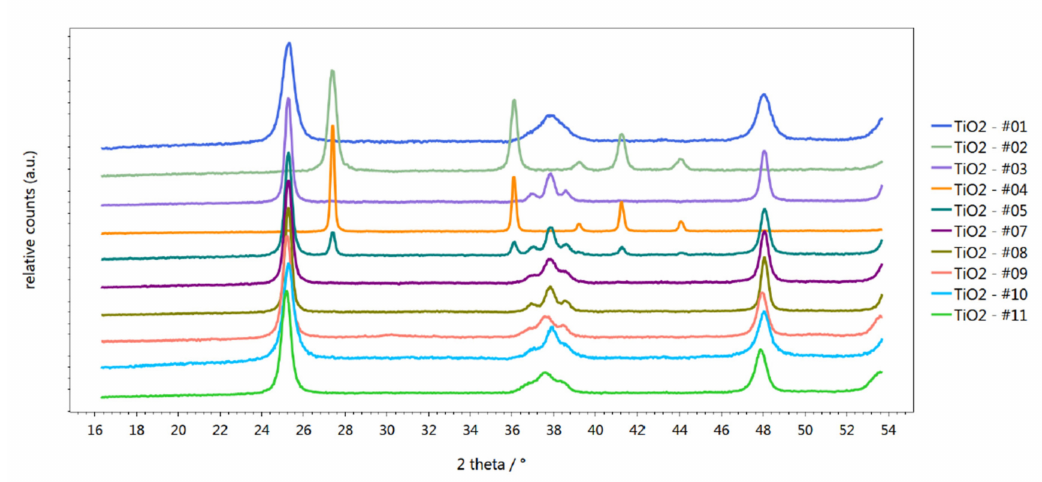
Figure 1. XRD pattern of investigated TiO 2 support materials.